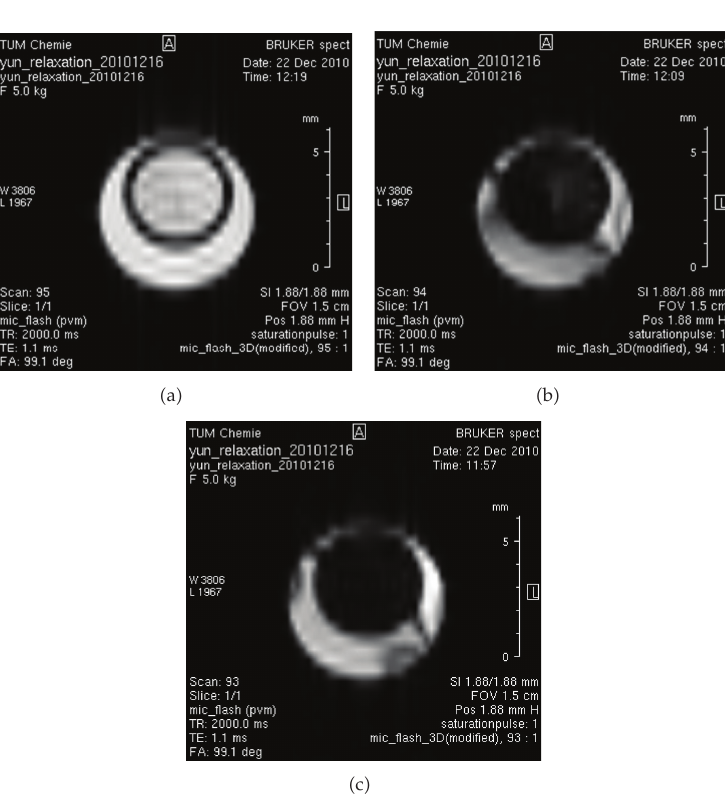
Figure 12: Experimental results on the contrast problems. The inner disk mimics the spin 1, while the outside ring mimics the spin 2. The two surfaces are separated by a thin black circle. (cid:3) a (cid:4) is a reference image before the application of the control field when the two spins are at the north pole of the Bloch sphere. (cid:3) b (cid:4) represent the contrast after a real experiment. The panel (cid:3) b (cid:4) corresponds to | M y | , while the panel (cid:3) c (cid:4) to | M | , that is, the remaining y and z magnetization components after the optimized pulse. A color has been z associated to each value of the contrast between 0 and 1, 0 and 1 corresponding, respectively, to the colors black and white. In the experiment, relaxation parameters are taken to be T 1 (cid:5) 1 . 3ms, T 2 (cid:5) 50ms for the inner sample and T 1 (cid:5) 1 . 3ms, T 2 (cid:5) 200ms for the outside